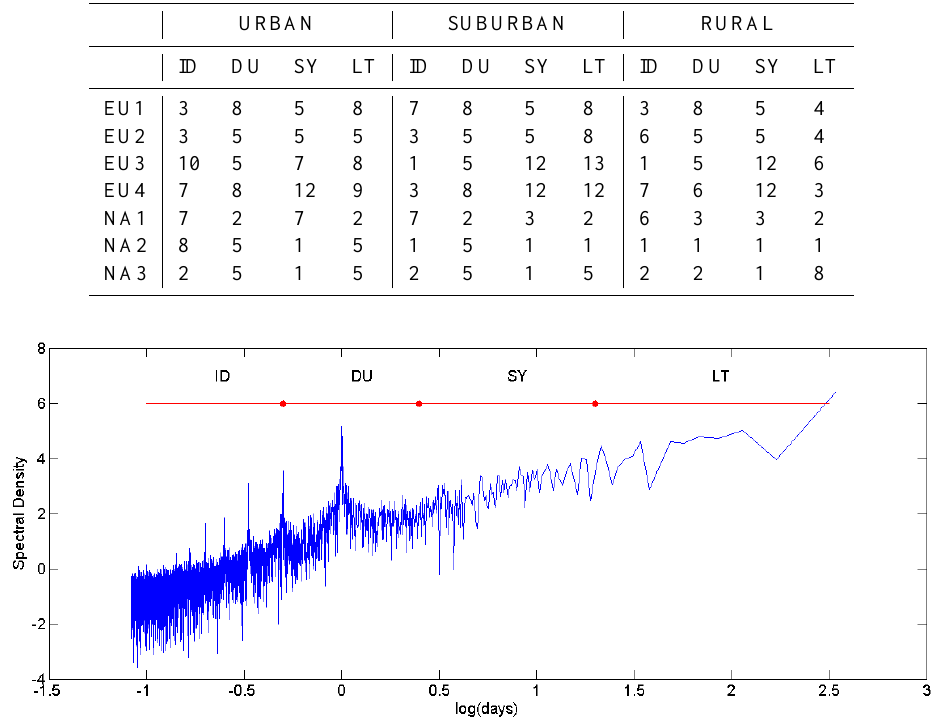
Table 5. Identification numbers of the deterministic models contributing most frequently to the kz model.